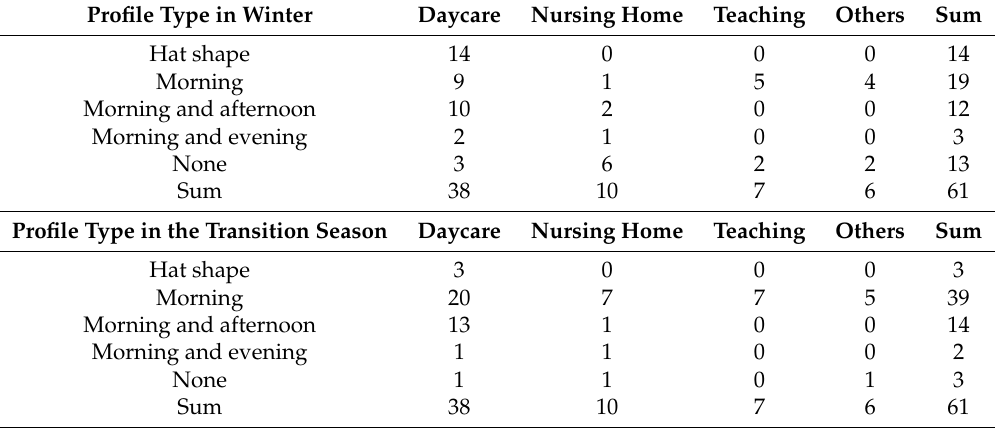
Table 6. Distribution of buildings of each peak profile type.